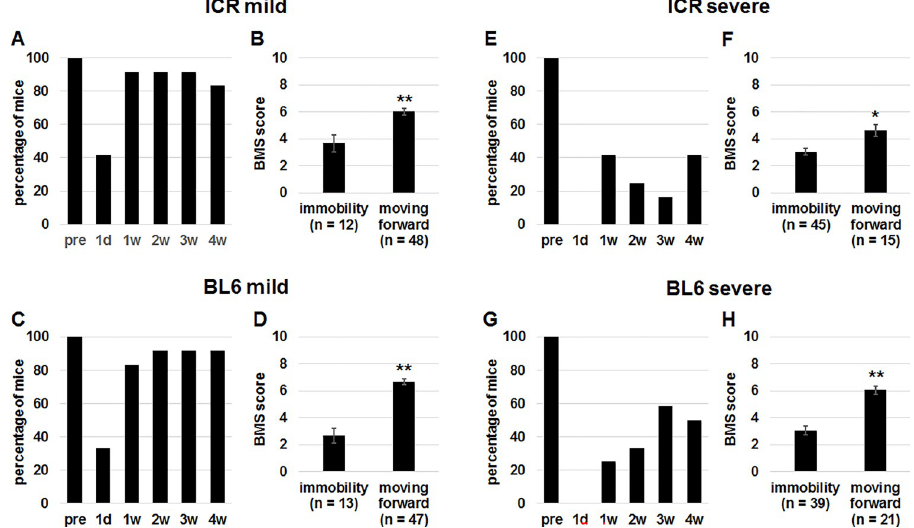
Fig 2. Comparison of BMS scores between mice which did not move forward on the beam and those which did after SCI. (A, C, E, G) Percentages of ICR (A, E) and C57BL/6 (C, G) mice before (pre) and 1 day (d), and 1, 2, 3 and 4 weeks (w) after mild (A, C) and severe (E, G) SCI which moved forward on the beam during the test. (B, D, F, H) ICR (B, F) and C57BL/6 (D, H) mice 1 day, and 1, 2, 3 and 4 weeks after mild (B, D) and severe (F, H) SCI were divided into those which did not move forward on the beam (immobility) and those which did. BMS scores of the 2 groups were compared. Mann-Whitney U test, � p < 0.05, �� p < 0.01.